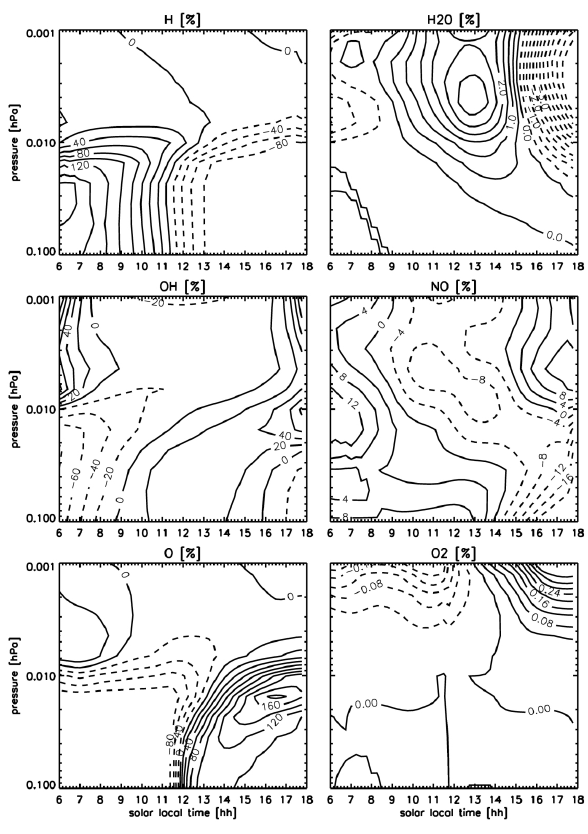
Fig. 7. HAMMONIA daytime variations of atomic hydrogen, water vapor (top row, left to right), hydroxyl, nitric oxide (middle row, left to right), atomic oxygen, and oxygen (bottom row, left to right) between 0.1 and 0.001hPa, given as deviation from the daytime mean in %.